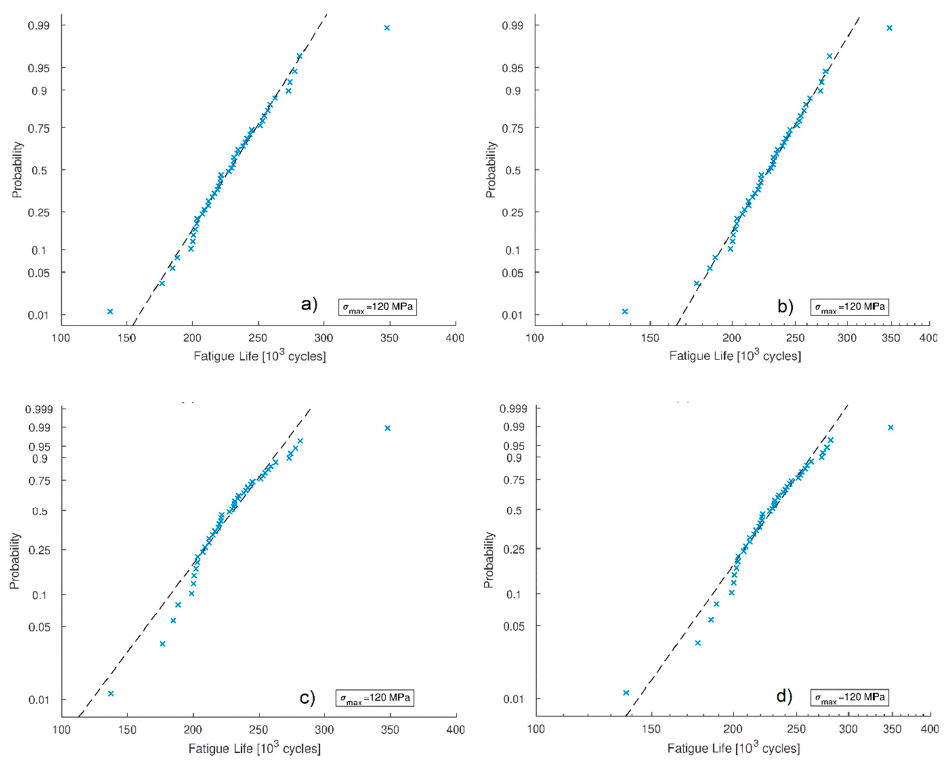
Figure 9. Fatigue life at 120 MPa: probability plots for normal ( a ), log-normal ( b ), extreme value ( c ) and Weibull ( d ) distributions.